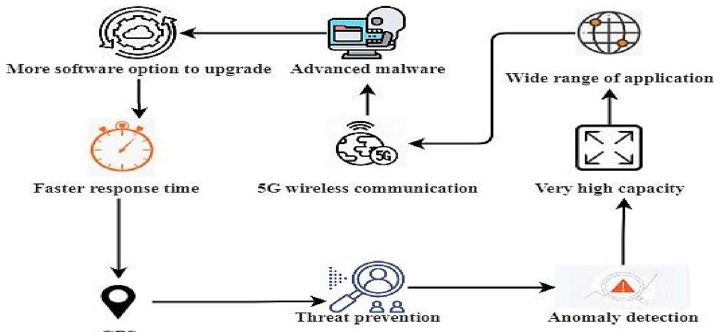
Fig. 4 The 5G wireless communication